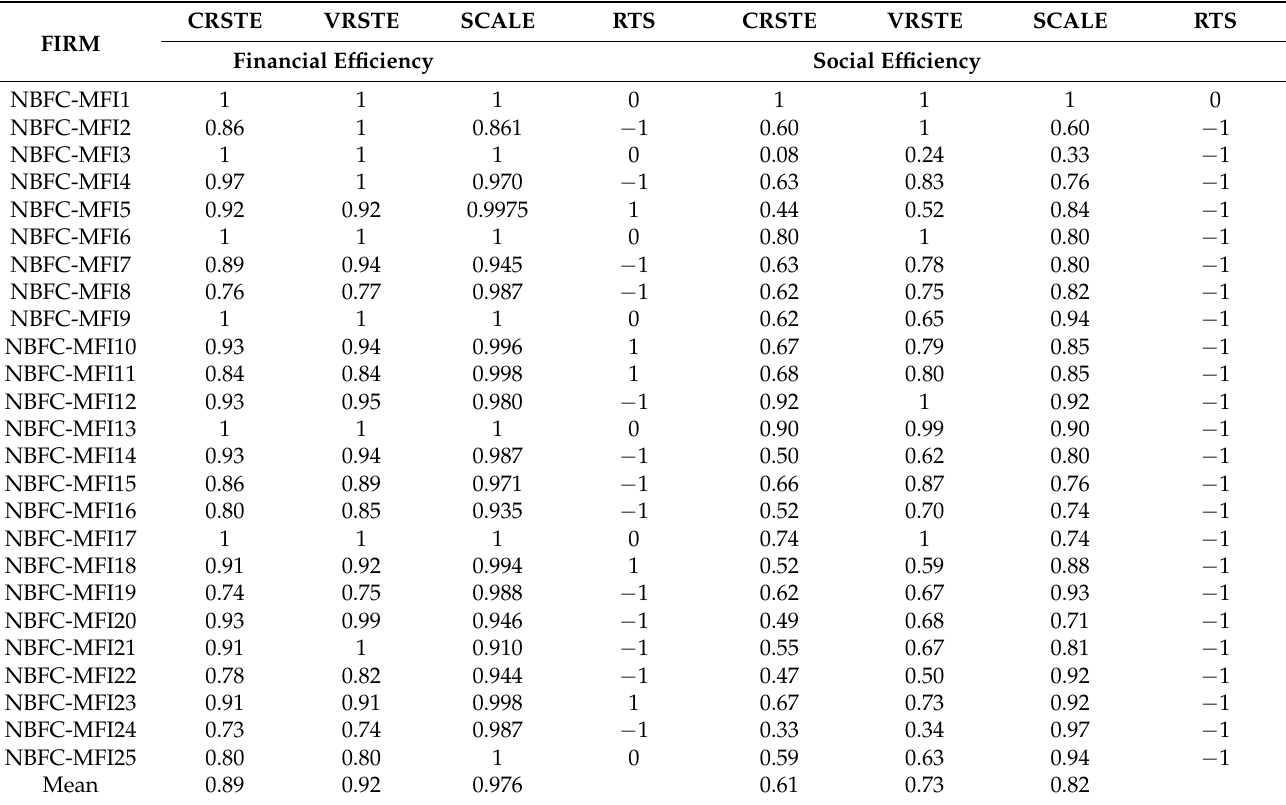
Table 6. Efficiency summary for the year